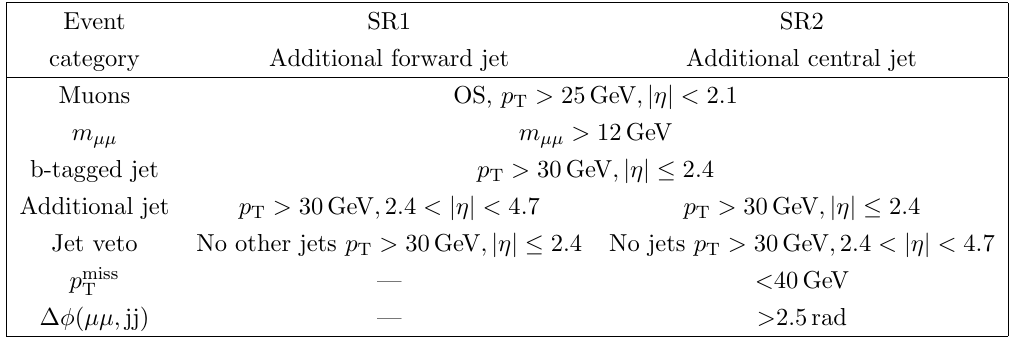
Table 1 . Event selection in the two search regions. A dash means that the variable is not used for